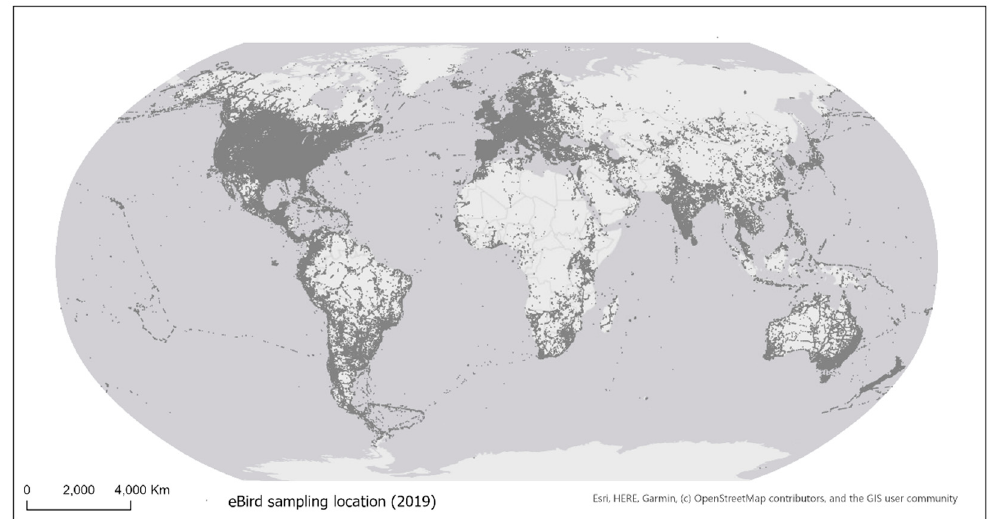
Figure 1. Spatial distribution of eBird sampling locations in 2019.